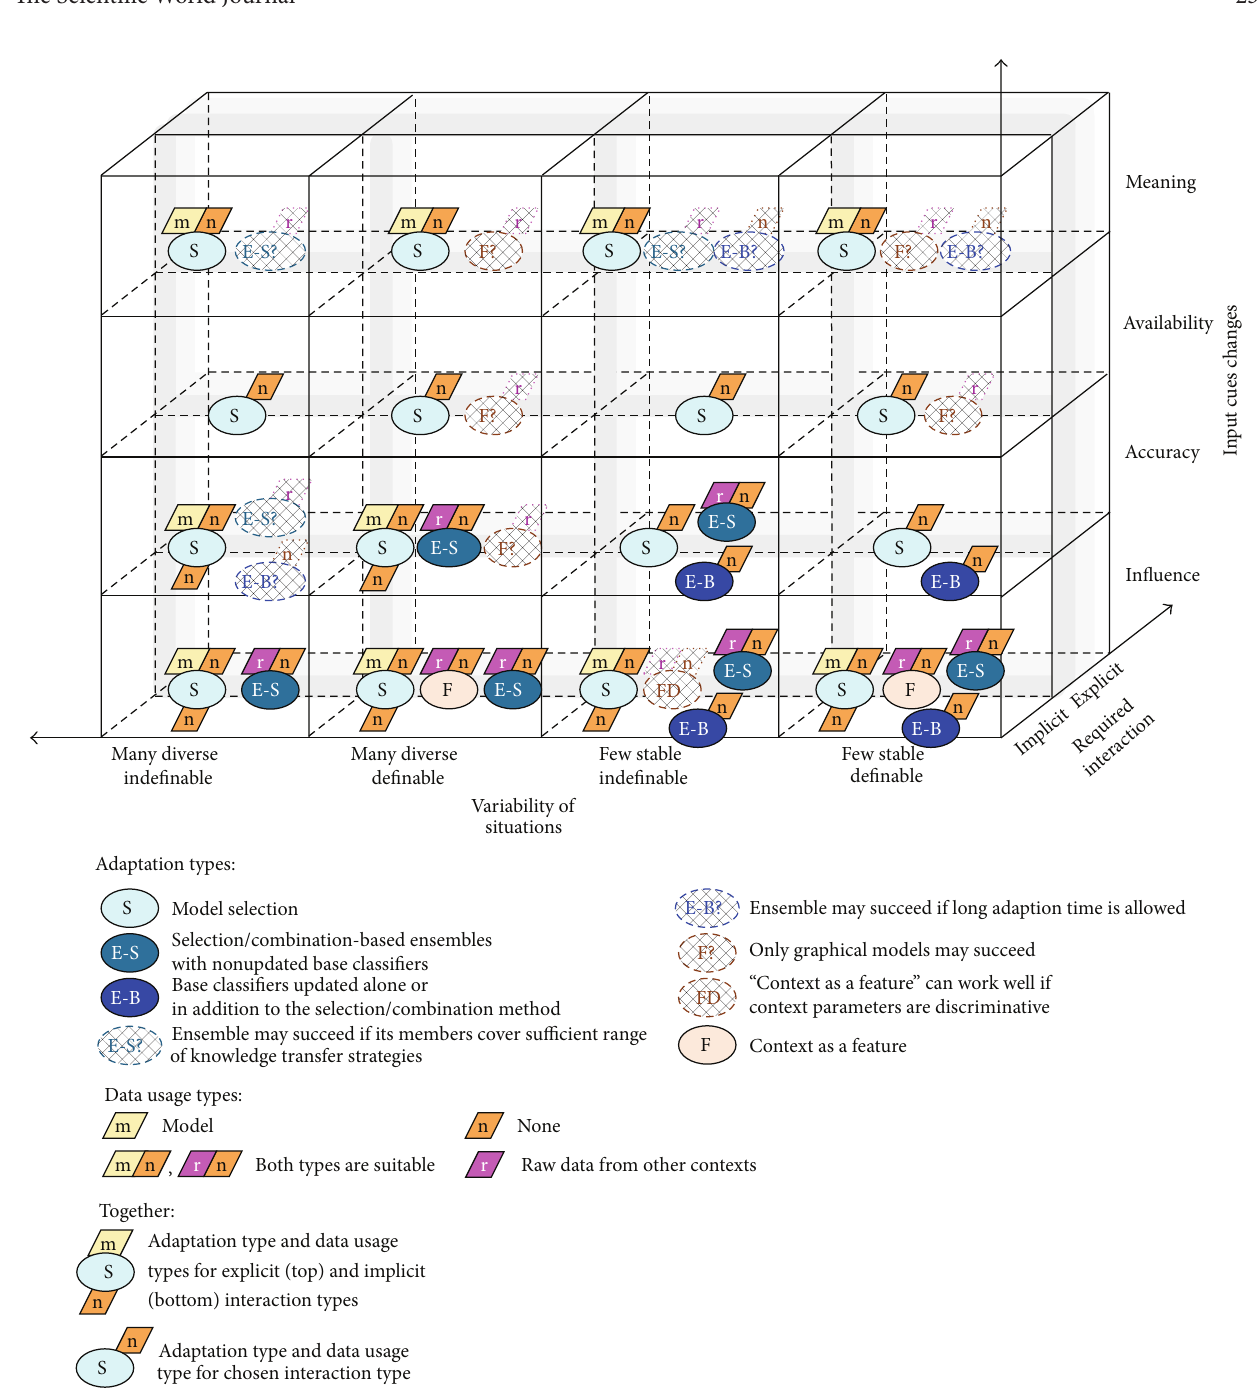
Figure 4: Recommended adaptation and data usage